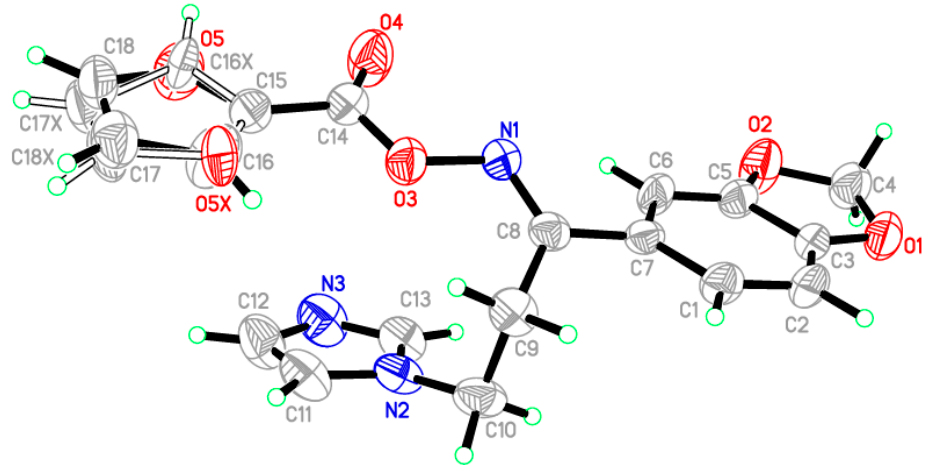
Figure 1. ORTEP diagram of the oximino ester 5 drawn at 40% ellipsoids for non-hydrogen atoms.